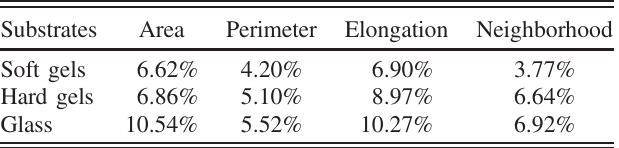
TABLE II. Quality of SVT-extracted measures. Relative aver- age deviation of the SVT-based morphological measures from the measures obtained via β -catenin stained, segmented, and hand- corrected pictures of the membrane, of fully tubular cells within the H . As discussed in our previous work, these deviations are PL comparable to or smaller than deviations that are inherent to uncorrected β -catenin segmented images